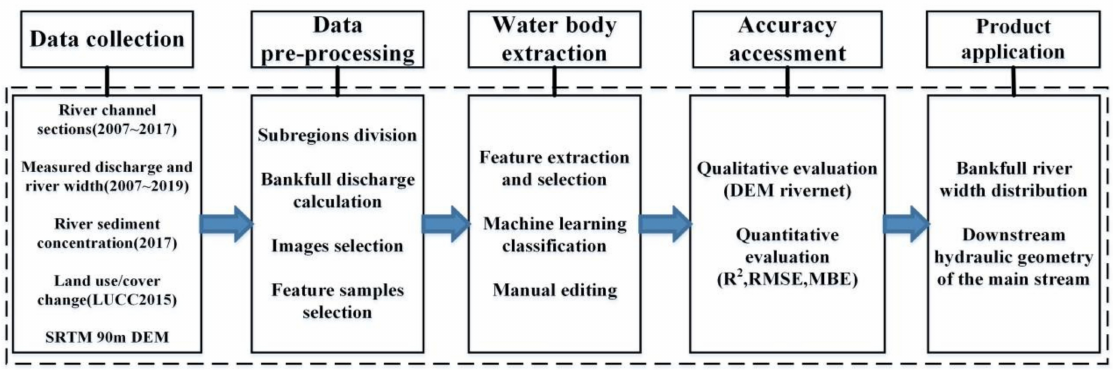
Figure 1. The technical flowchart of river extraction under bankfull